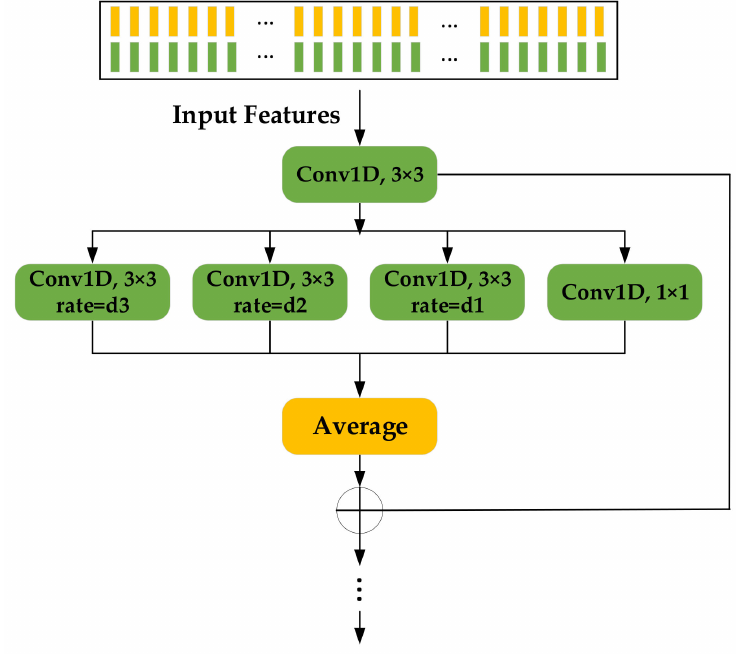
Figure 3. Architecture of DBNet. d 1, d 2 and d 3 are the dilation rates of temporal 1D